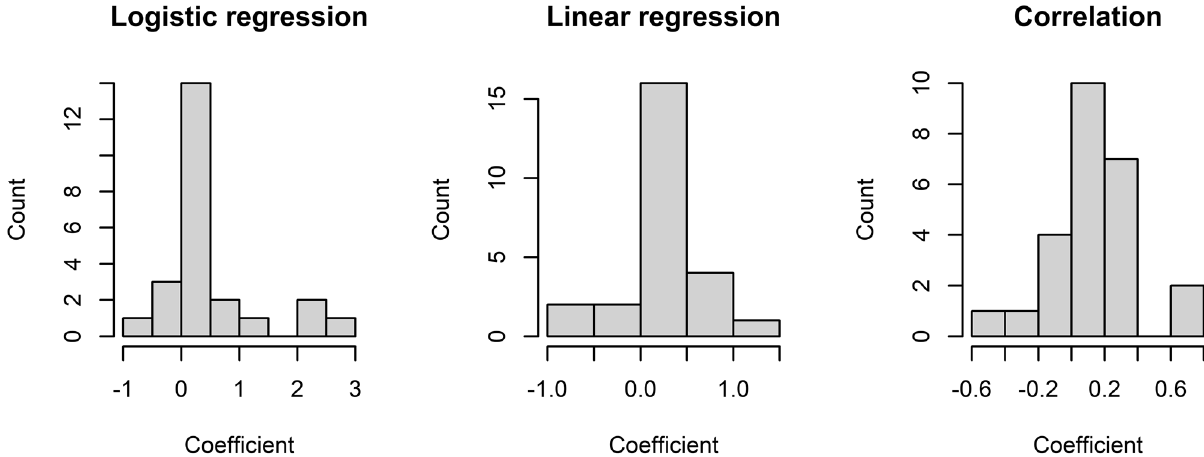
Figure 3. Distribution of measures (regression/correlation coefficients) of urge-tic association in children and adolescents. More positive values indicate a stronger positive urge-tic association, with more/more intense tics at times of elevated urge. Negative values indicate a reversed urge-tic pattern. Values near 0 indicate no or only a weak